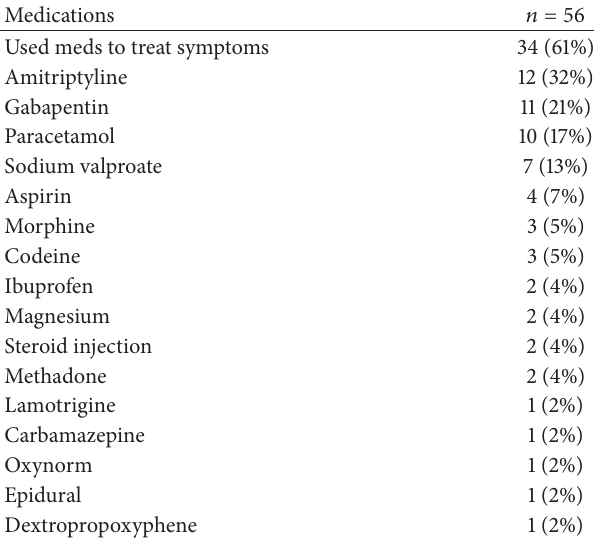
Table 1: Percentage of people who have used medications to treat their symptoms and the medications that they could recall that they had tried.